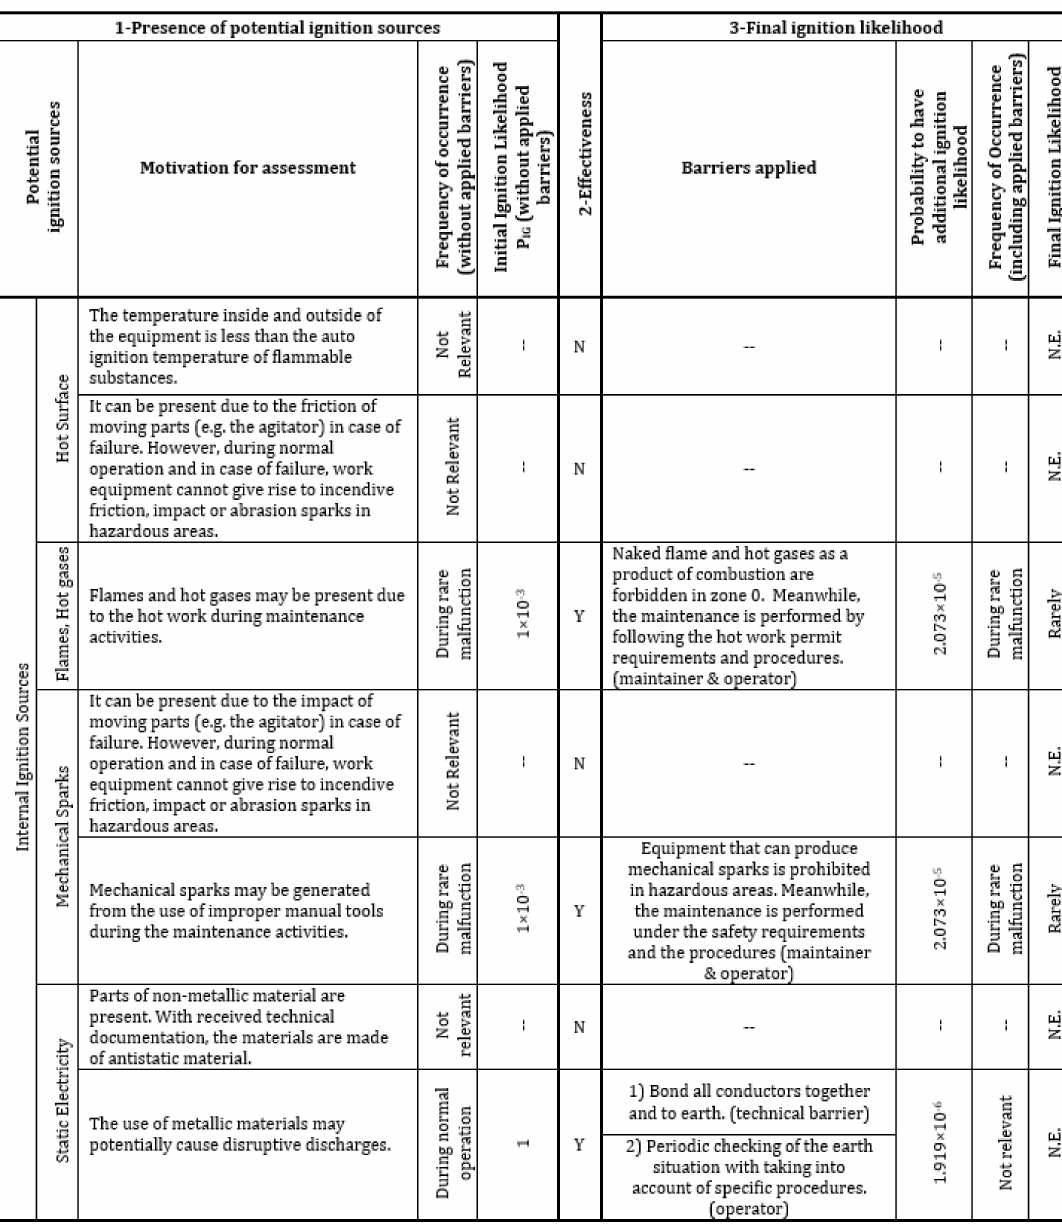
Figure A1. Internal ignition sources estimation within the ATEX-HOF